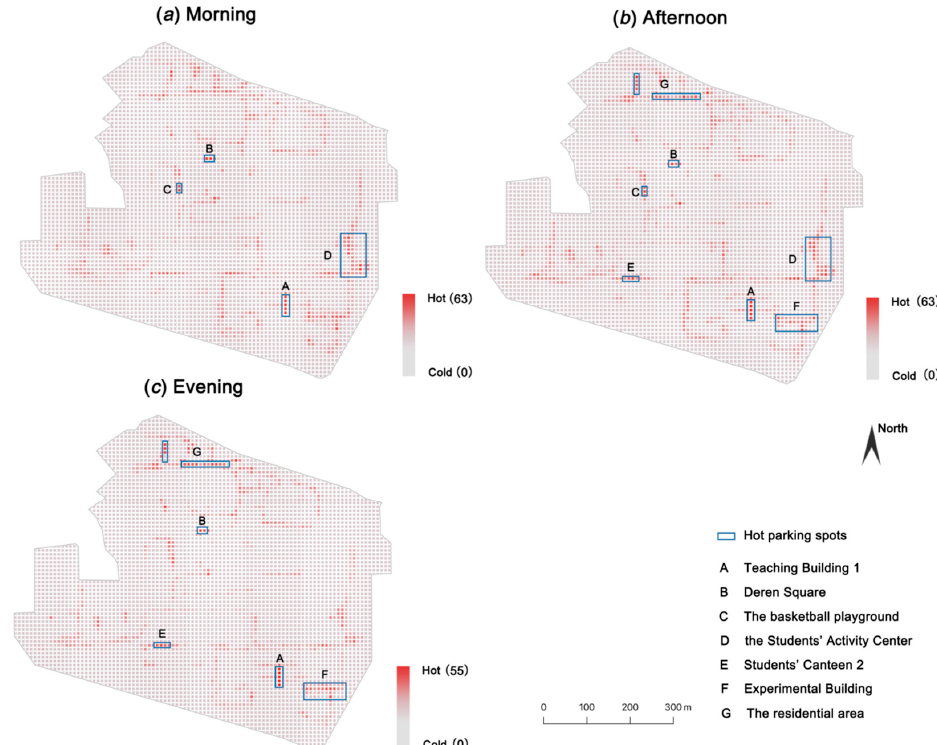
Figure 5. Hot parking zones in three time periods, including ( a ) the morning, ( b ) the afternoon and ( c ) the evening. The redder the grids, the more parking they accommodate. The grids circled by the blue rectangles represent the regions of highest parking demand. The source of the map is OpenStreetMap.